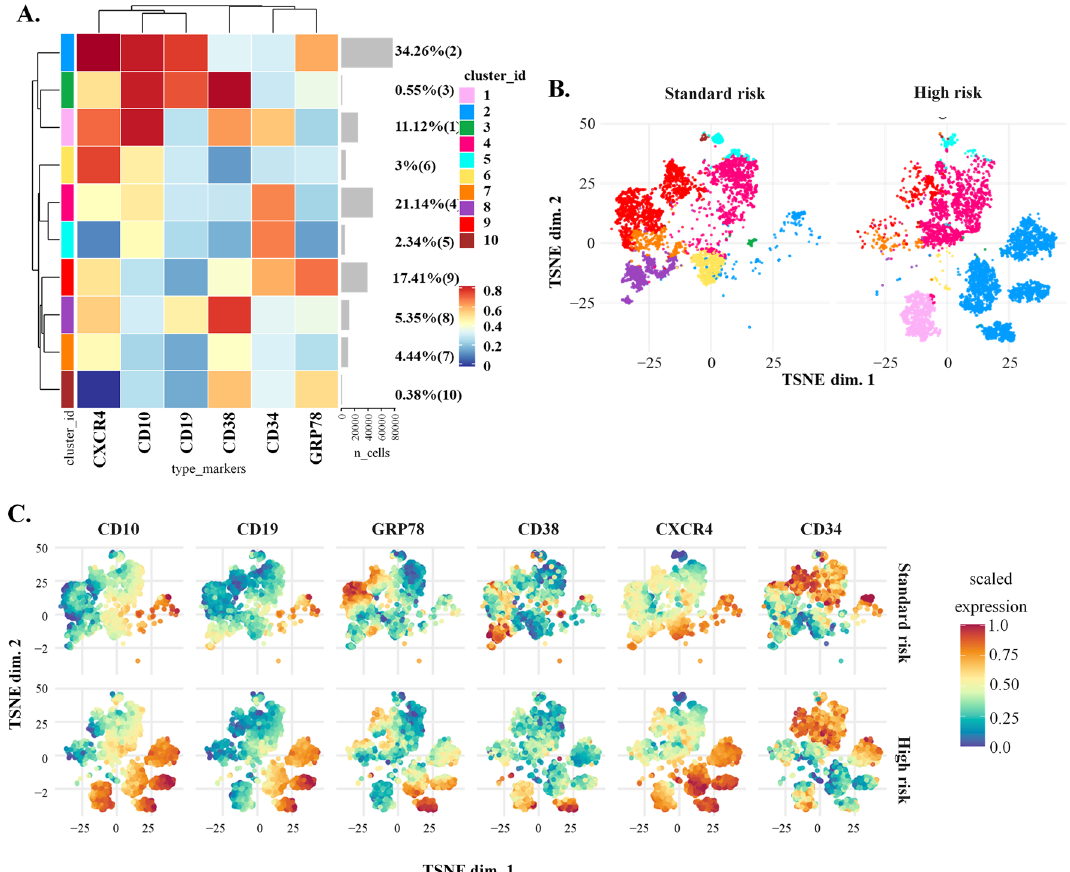
Figure 3. Dimensional reduction of flow cytometry data from Standard and High-risk LLA patients. ( A ) Cluster organization and heatmap of the median marker intensities of the lineage markers and sGRP78. ( B ) TSNE based on the 10 clusters obtained by FlowSOM comparing LLA Standard-risk group (Standard-risk) against LLA High-risk group (High-risk). ( C ) TSNE showed the expression level of each marker separated by group risk. Heat maps were built by using Cytometry dATa anALYSis Tools (CATALYST). https:// bioco nduct or. org/ packa ges/3. 10/ bioc/ html/ CATAL YST.